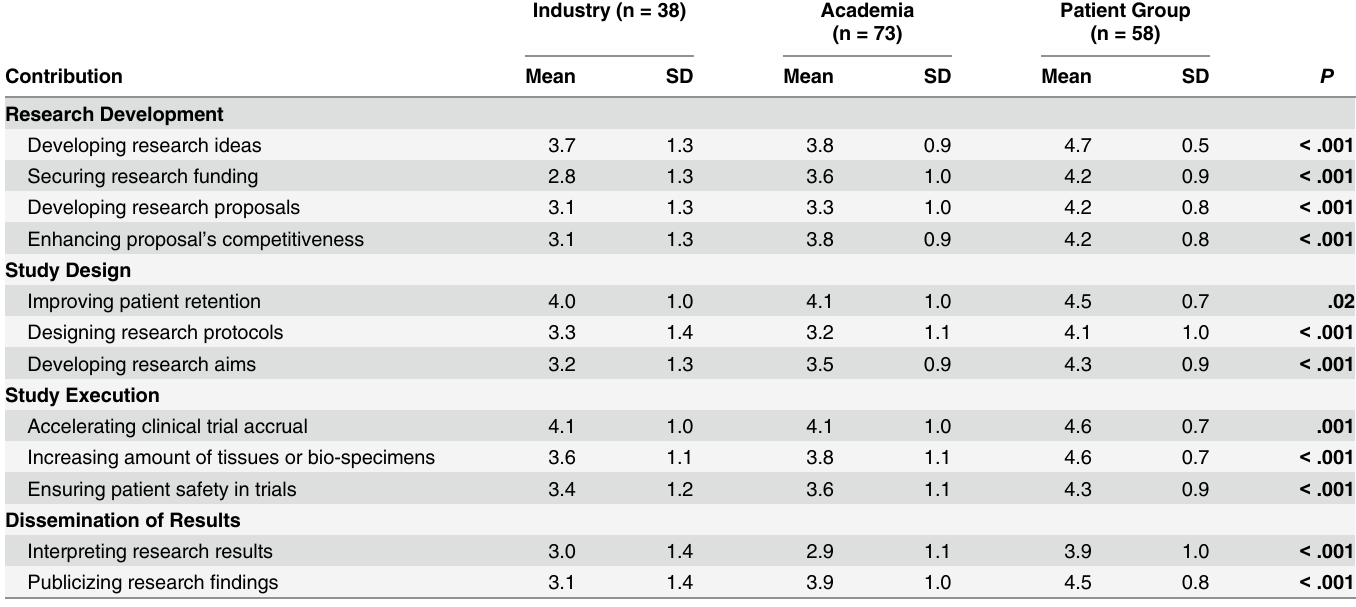
Table 2. Importance or Value of Patient Groups in Research *